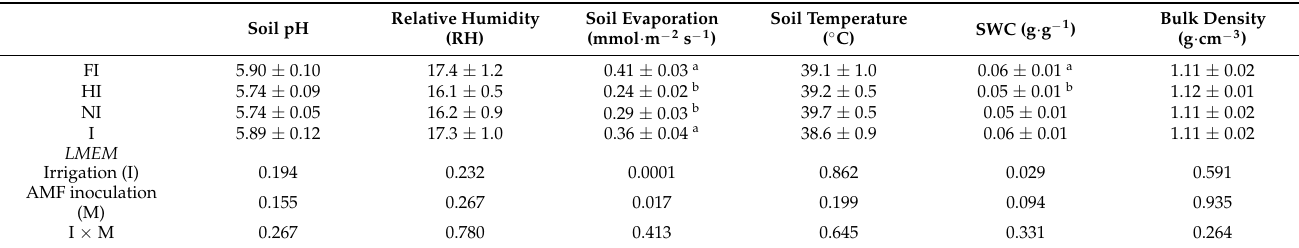
Values represent means ± SE (n = 8) separated by Kenward-Roger method and Tukey’s p -value adjustment ( p ≤ 0.05). Different letters indicate significant differences as affected by treatment application (FI, HI, NI, or I) according to the main factors in the linear mixed- effect model.